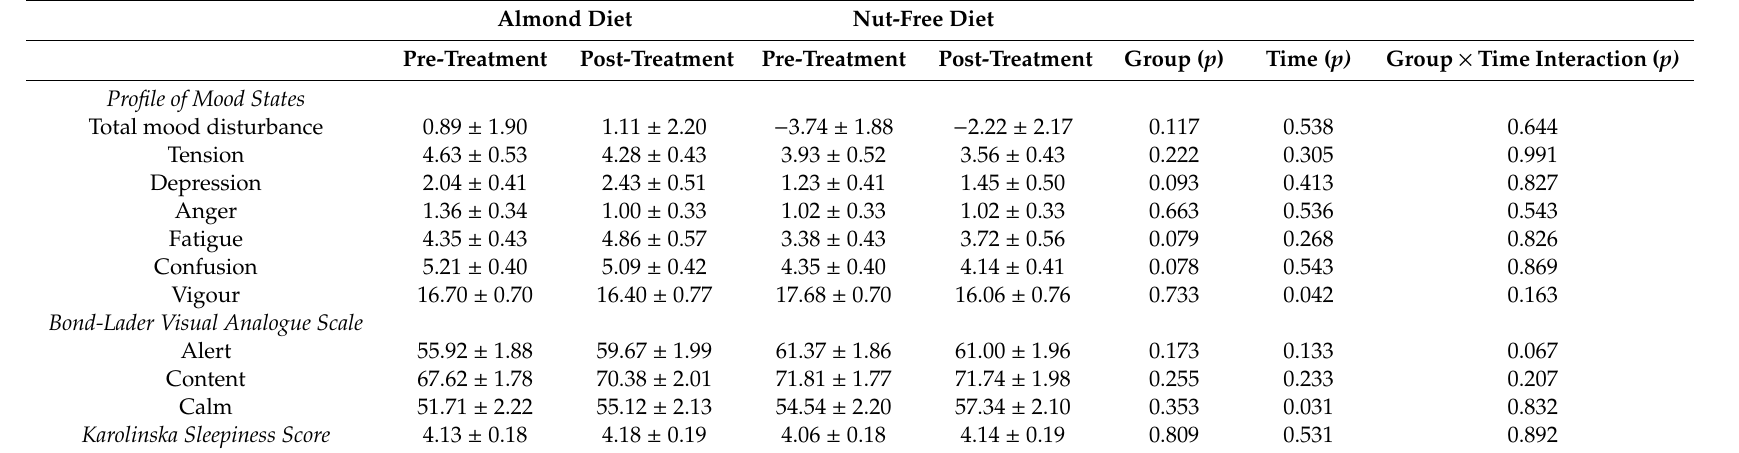
Table 4. E ff ect of Treatment on